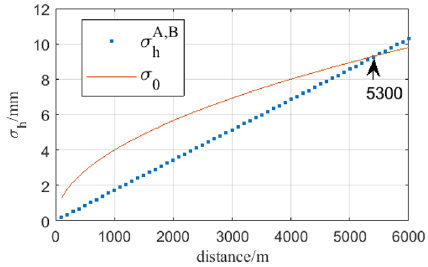
Figure 4. The precision estimation of simultaneous reciprocal trigonometric